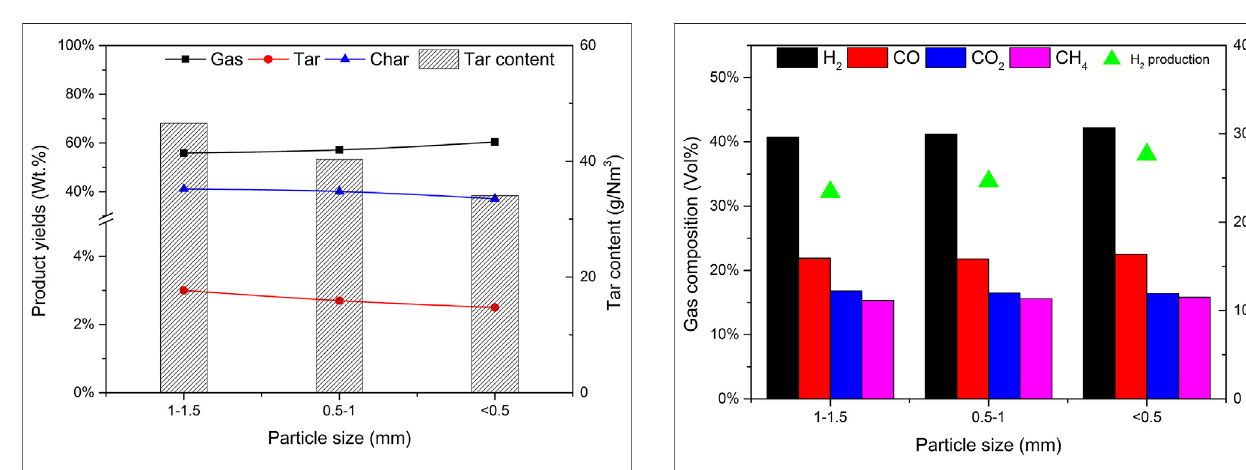
FIGURE 14 | Effect of particle size on product yields and tar content. FIGURE 15 | Effect of particle size on gas composition and hydrogen